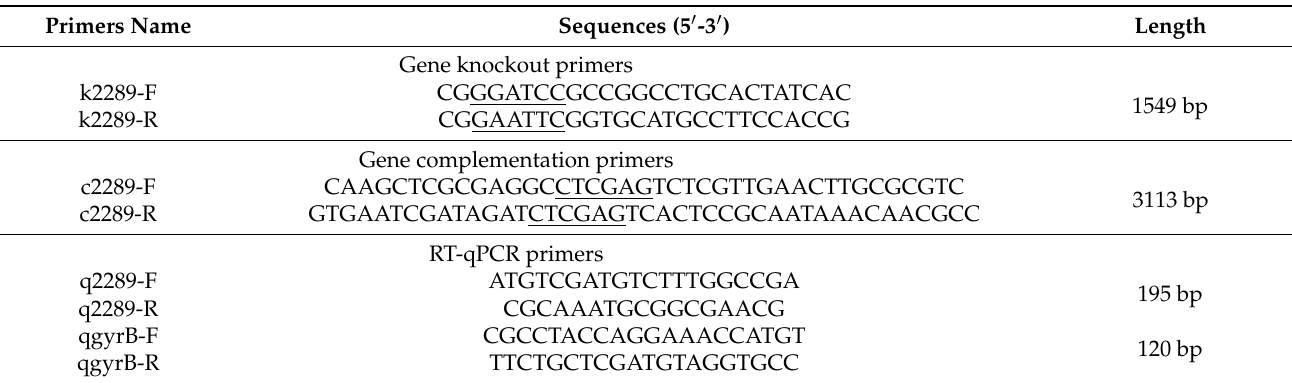
Table 2. Primers used in this